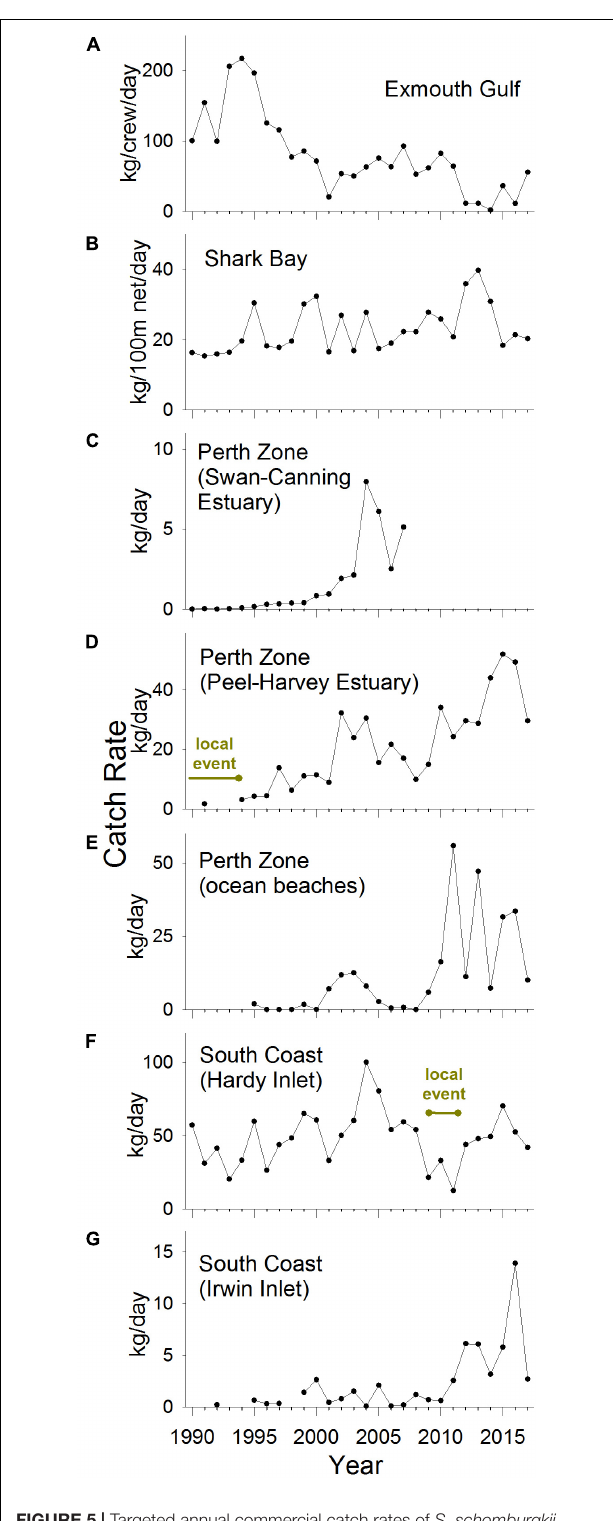
FIGURE 5 | Targeted annual commercial catch rates of S. schomburgkii, 1990–2017, in (A) Exmouth Gulf, (B) Shark Bay, (C) Perth Zone (Swan-Canning Estuary), (D) Perth Zone (Peel-Harvey Estuary), (E) Perth Zone (ocean beaches), (F) South Coast (Hardy Inlet), and (G) South Coast (Irwin Inlet). “Year” refers to calendar years except for (E,F) which are fiscal